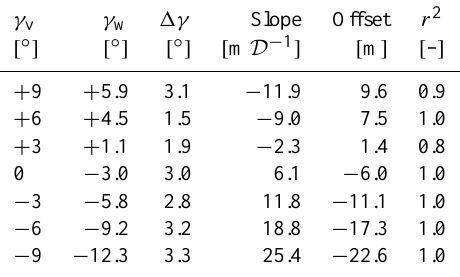
Figure 9. Diagram of our interpretation of the measured near-wake path for an individual yaw misalignment, showing what we call a deviation shift with respect to wind tunnel paths found in publica-